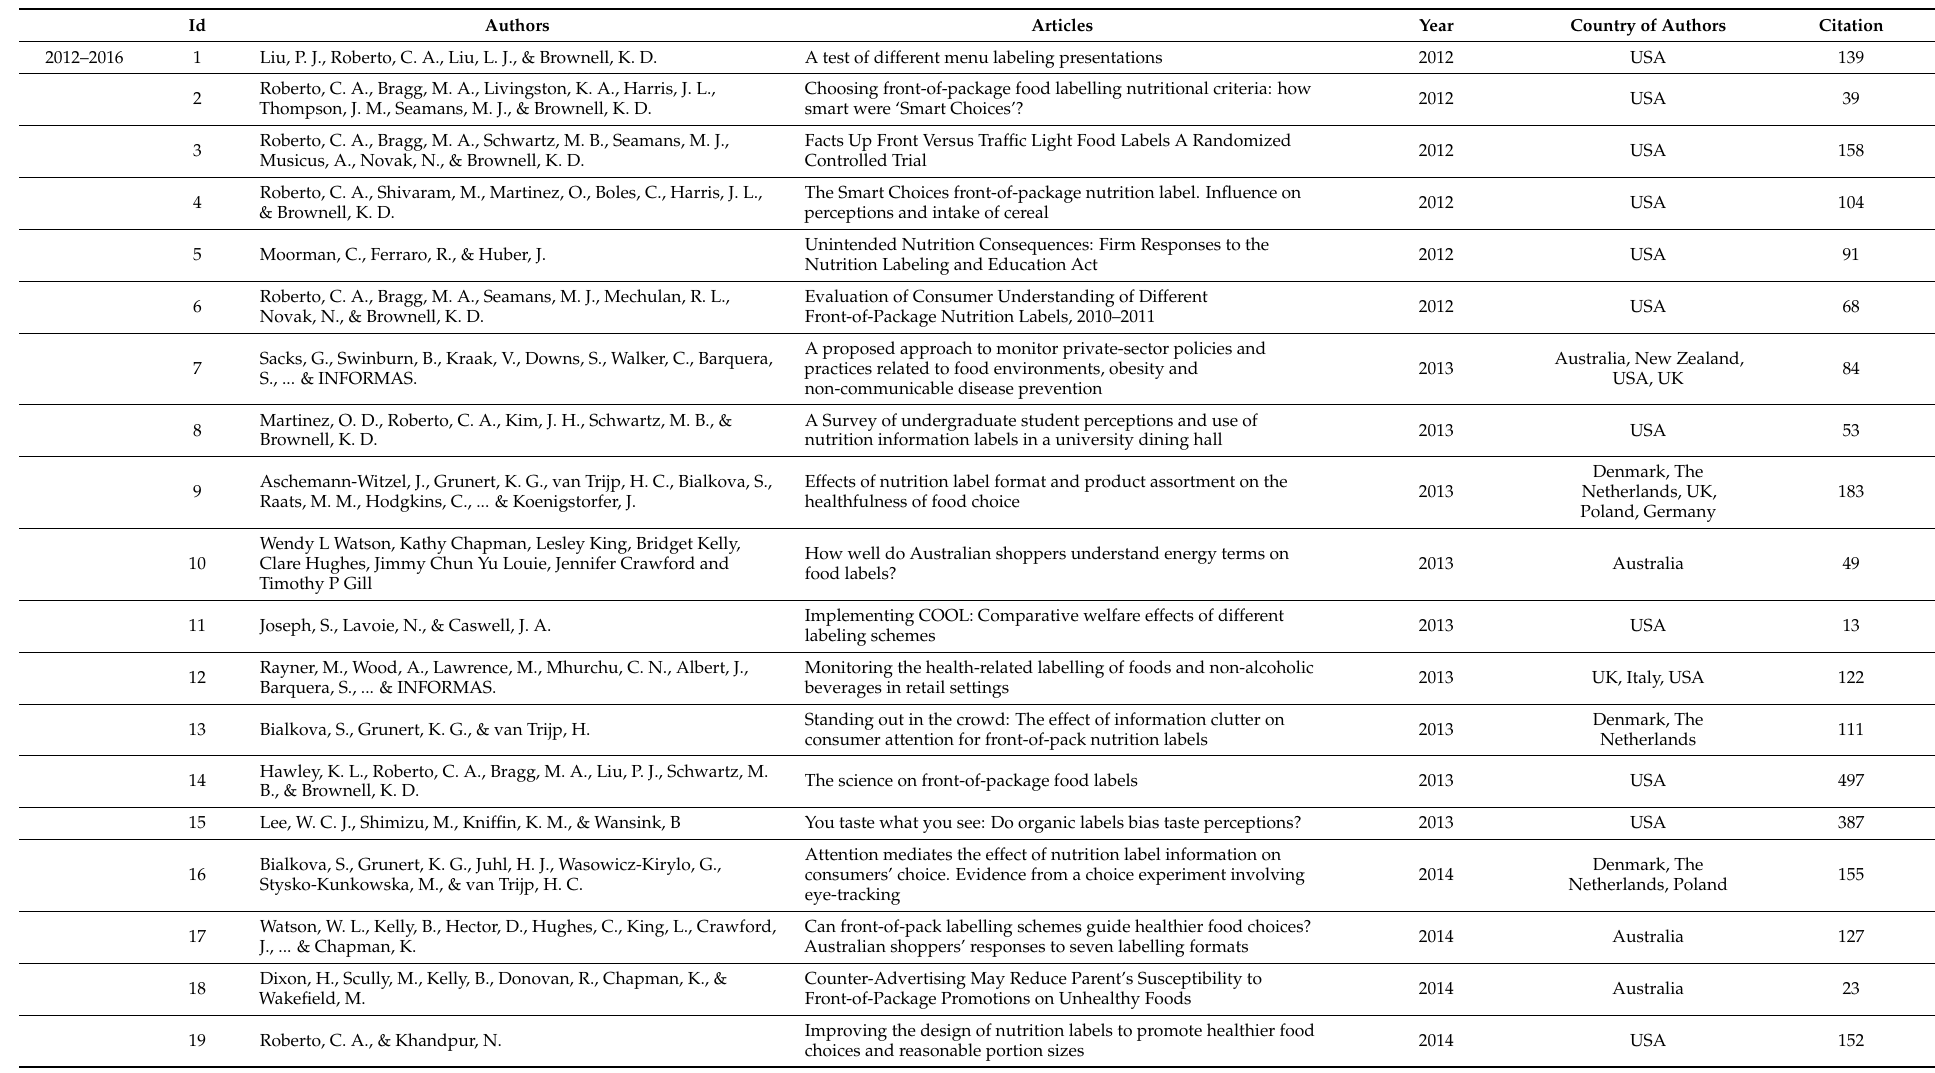
Table 10. Composition of co-citation network 4 in terms of authors, articles, year, country of authors and citation.